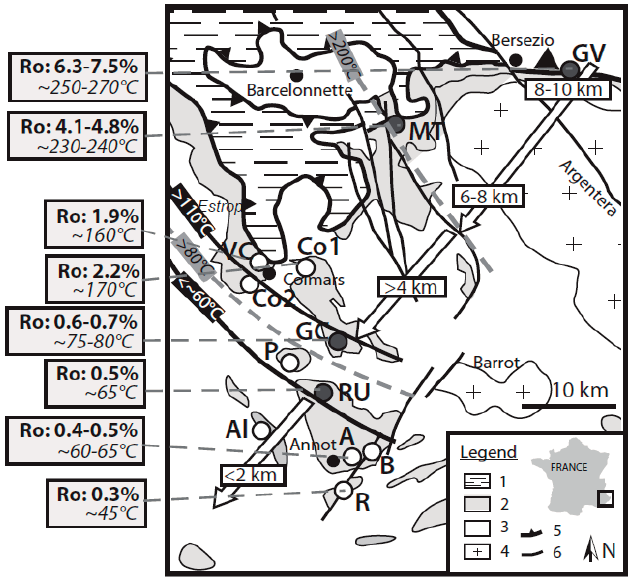
Figure 1. Sampling sites and thermal data available for the study area (modified from Labaume et al. [33]). Dots represent the location of the samples analyzed in this study, with dark dots marking samples for which vitrinite reflectance data had been previously obtained on the same samples and white dot where vitrinite reflectance data were obtained from different samples in the same area. Vitrinite reflectance data and corresponding estimated temperatures are from Labaume et al. [34,35] and Cavailhes [36]. Isotherms were placed according to vitrinite data (ibid.), apatite fission tracks analyses and silica diagenesis [33,36]. 1: Embrunais-Ubaye nappes; 2: Middle Eocene to